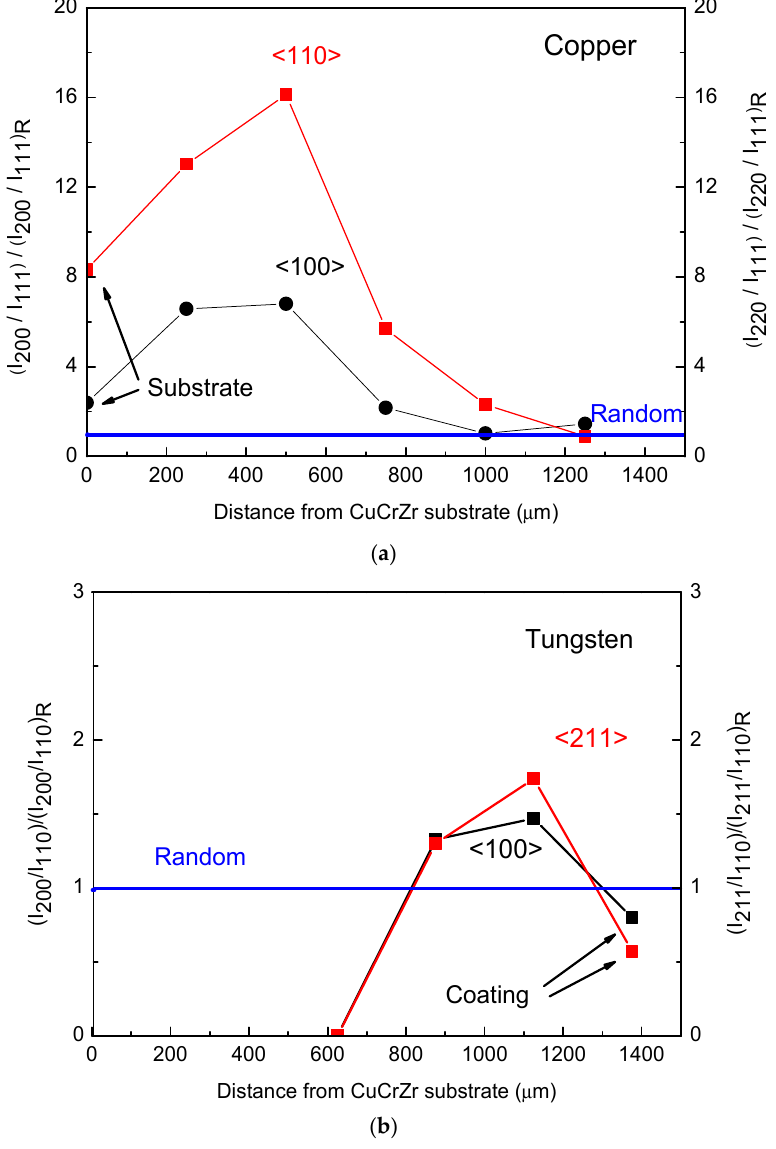
Figure 7. Index describing texture components of Cu ( a ) and W ( b ) in the seven examined zones. The CuCrZr substrate has a principal <110> texture and a secondary <100> cubic component. In the first deposited layers of Cu (zones 1 and 2), these texture components become even stronger; subsequently, starting from a distance of ~500 µm, they progressively weaken, and finally the Cu grains take on an almost random orientation near the coating (zones 4 and 5). The XRD patterns of W collected from zones 1 and 2 exhibit only a very weak (110) peak with intensity comparable to the background; thus, they are not suitable for describing a possible texture. In the zones 4 and 5 and the coating, the relative intensities do not significantly diverge from those corresponding to the random grain orientation; only weak <100> and <211> texture components were observed there.